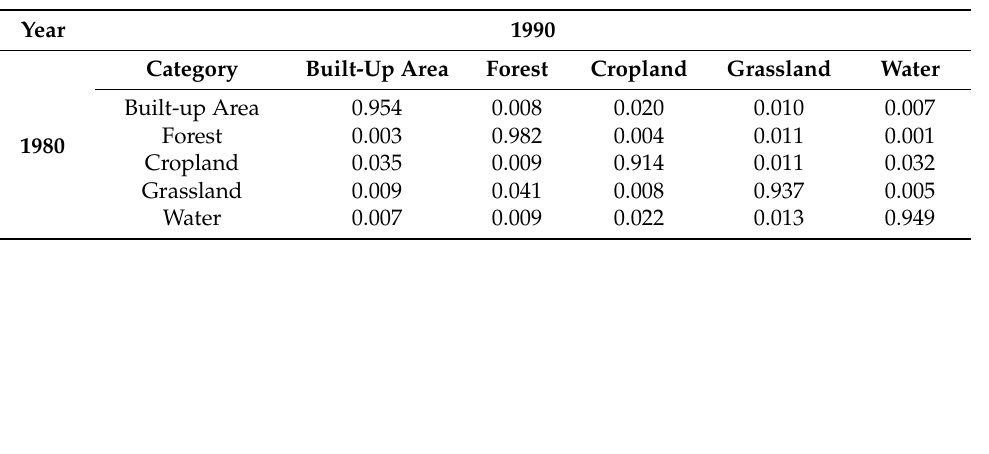
Table 6. Transition Matrix from